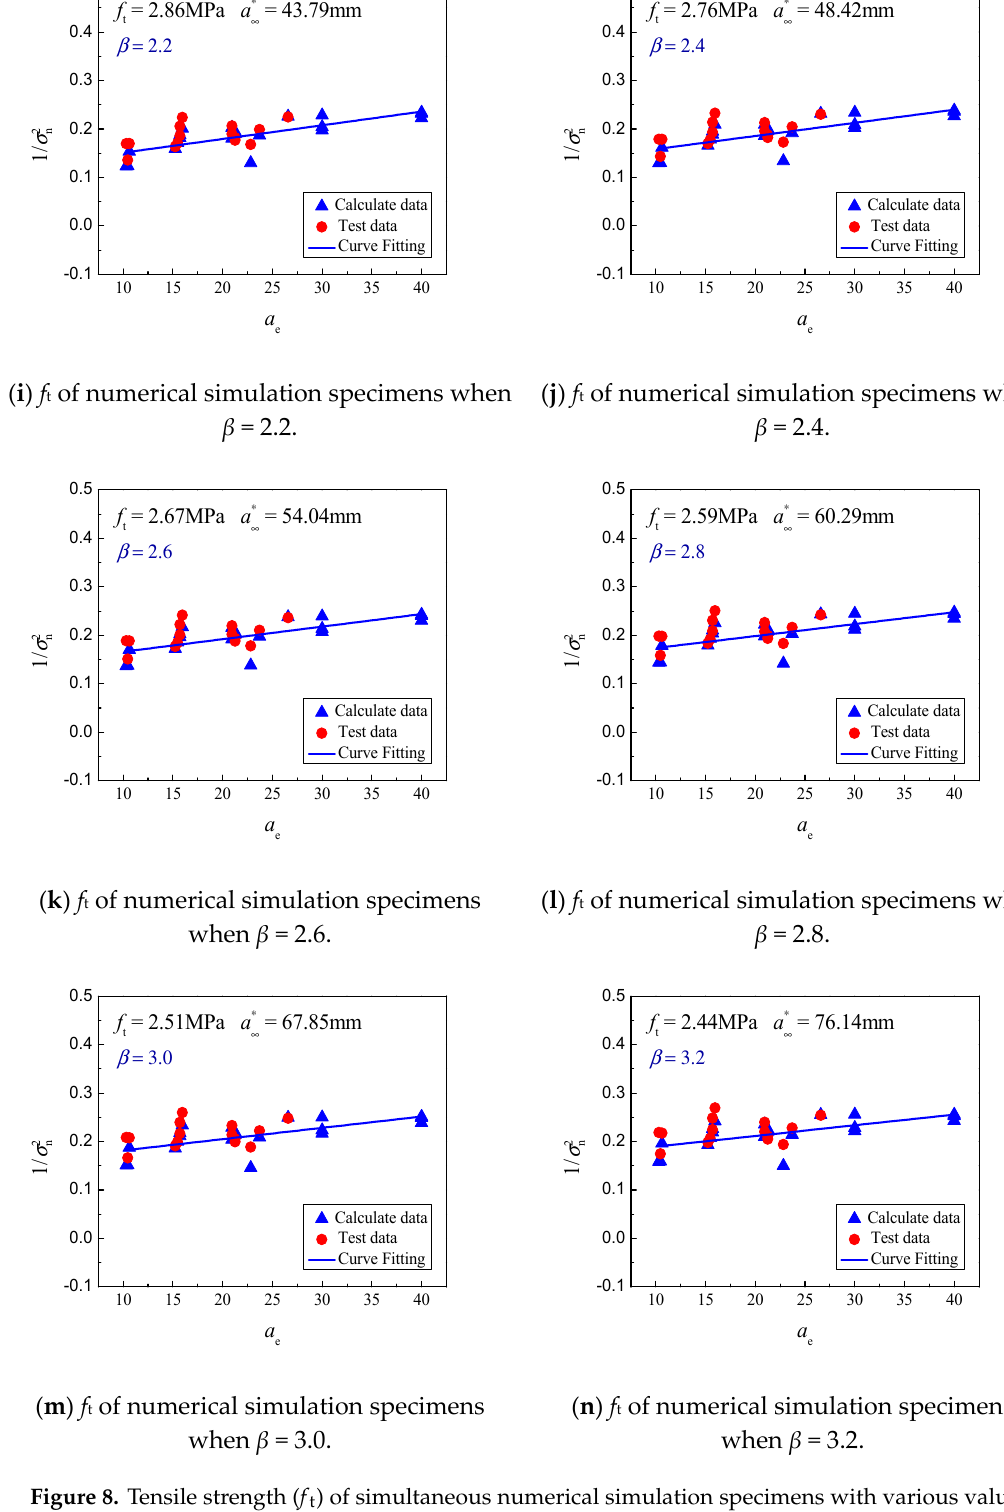
Figure 8. Tensile strength ( f t ) of simultaneous numerical simulation specimens with various values of β .